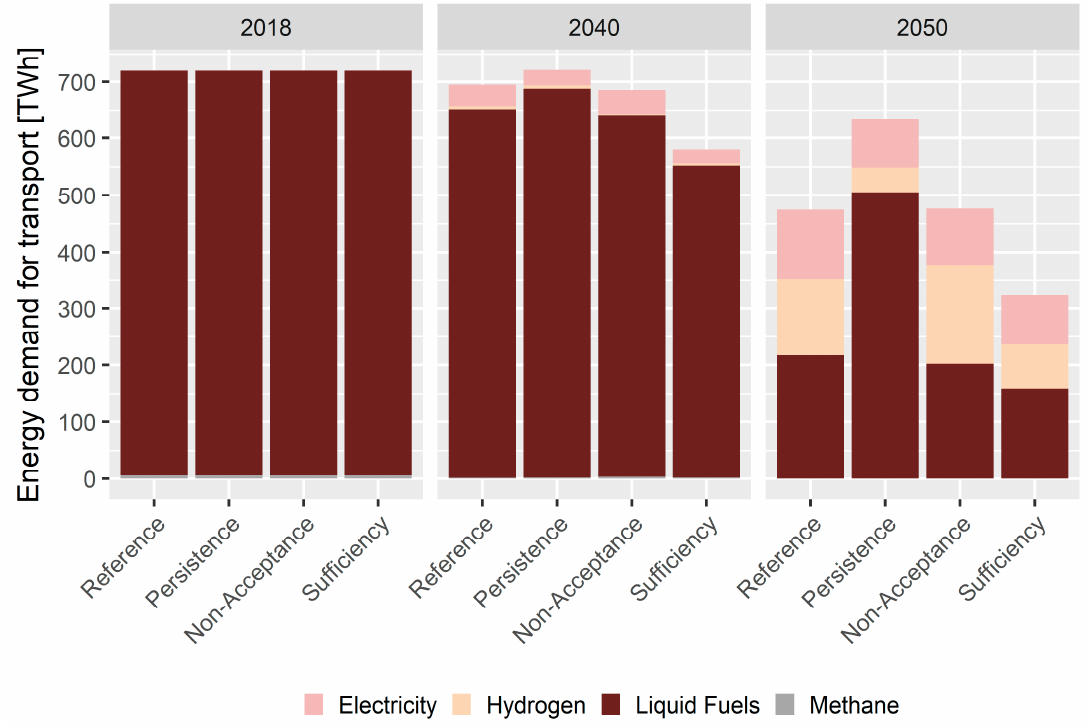
Figure 9. Present and future energy carrier mixes for transportation for the defined scenarios (results calculated with REMod).